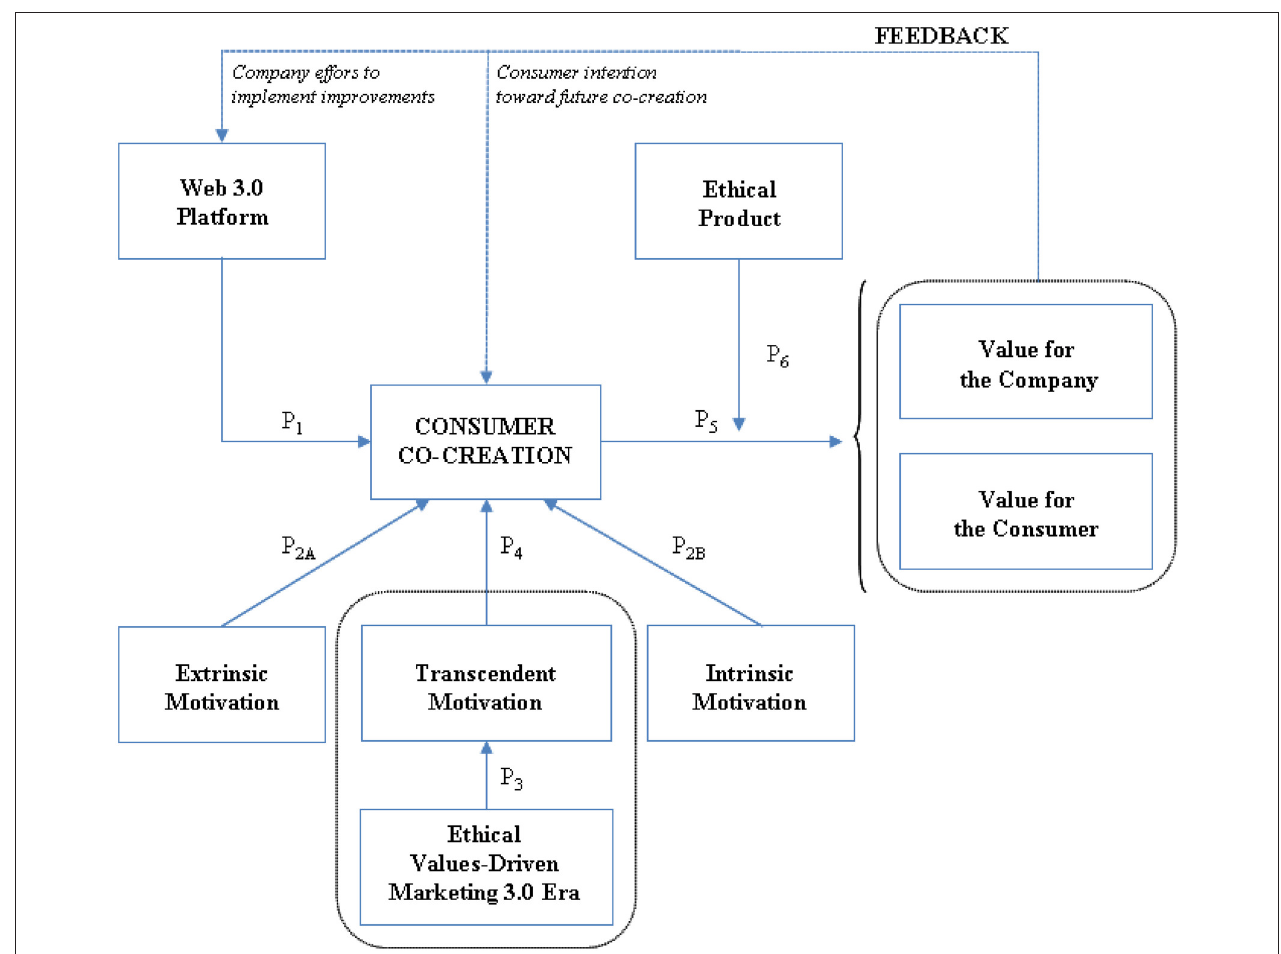
FIGURE 2 | An integrative model of the causes of the co-creation process and its positive